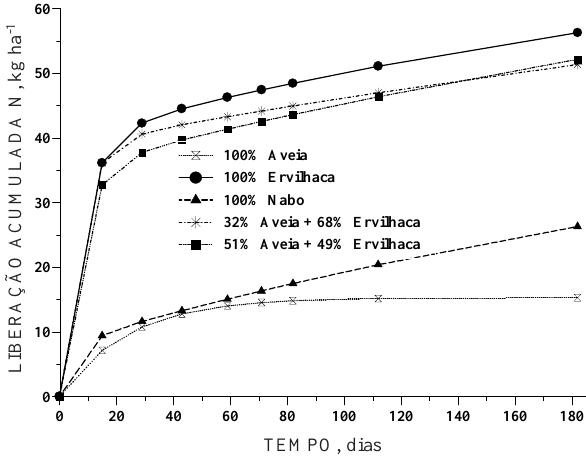
Figura 4. Liberação acumulada de nitrogênio dos resíduos culturais de plantas de cobertura solteiras e consorciadas, em avaliações realizadas até 182 dias após a distribuição das bolsas de decomposição na superfície do